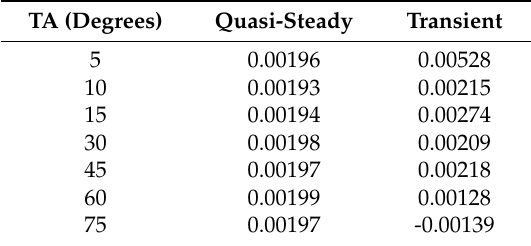
Table 6. Rotor torque coefficient at several TAs by both methods.